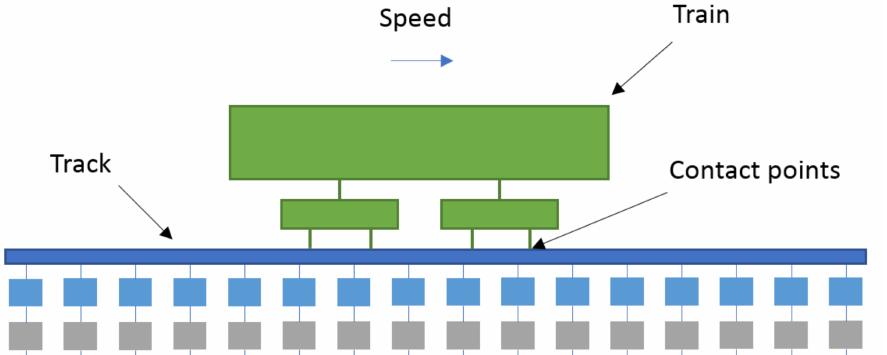
Figure 1. Schematic of the coupled